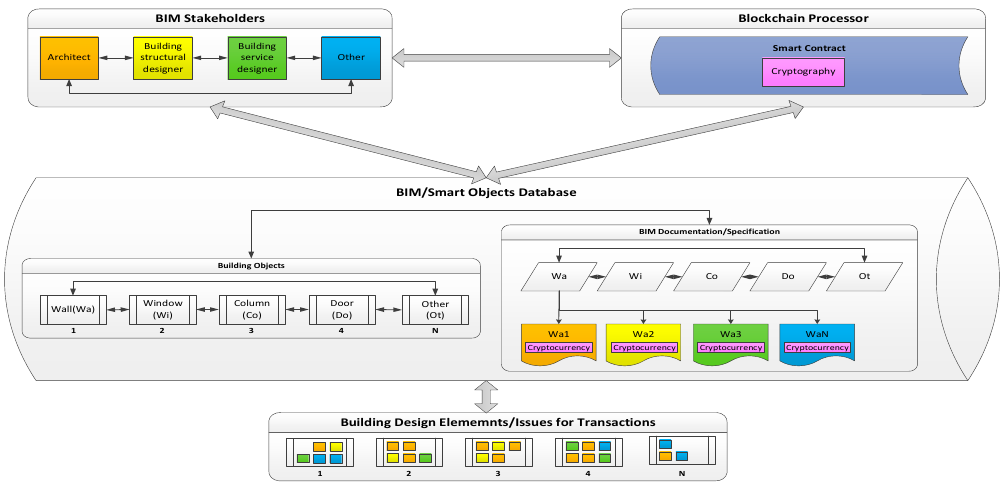
Figure 3. The user level (BIM stakeholders) driven blockchain (BC) technology for transaction in BIM process flow in information management of building construction projects (devised by the authors based on the literature).